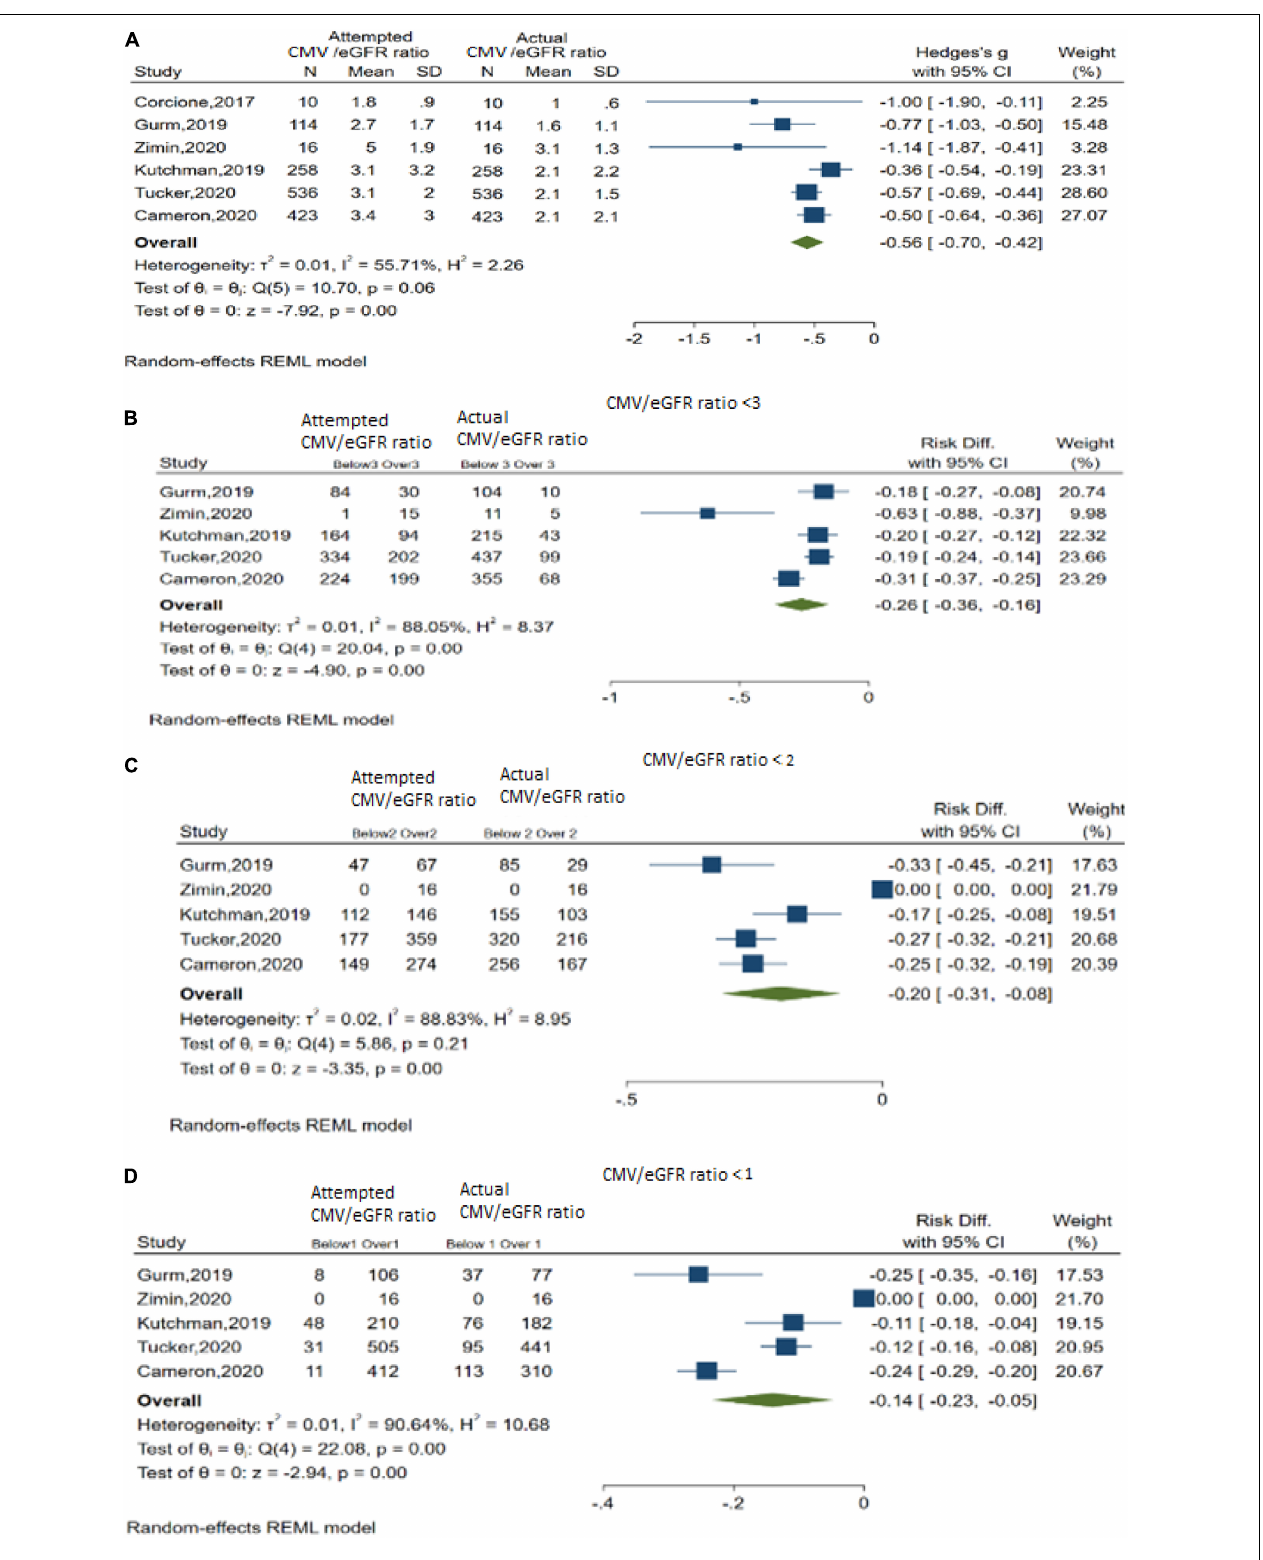
FIGURE 4 | Contrast media volume/baseline renal function ratios. (A) Overall meta-analysis across 6 studies. (B) Meta-analysis for CMV/eGFR ratio < 3. (C) Meta-analysis for CMV/eGFR ratio < 2. (D) Meta-analysis for CMV/eGFR ratio < 1.